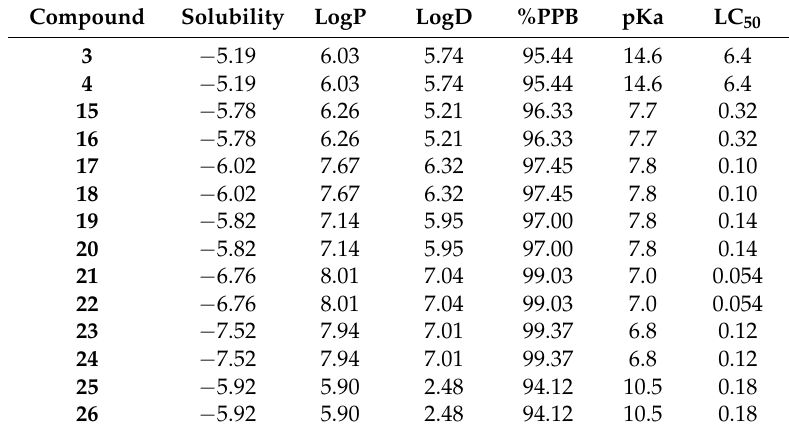
Table 2. Absorption, distribution, metabolism, and excretion (ADME) property prediction of compounds.